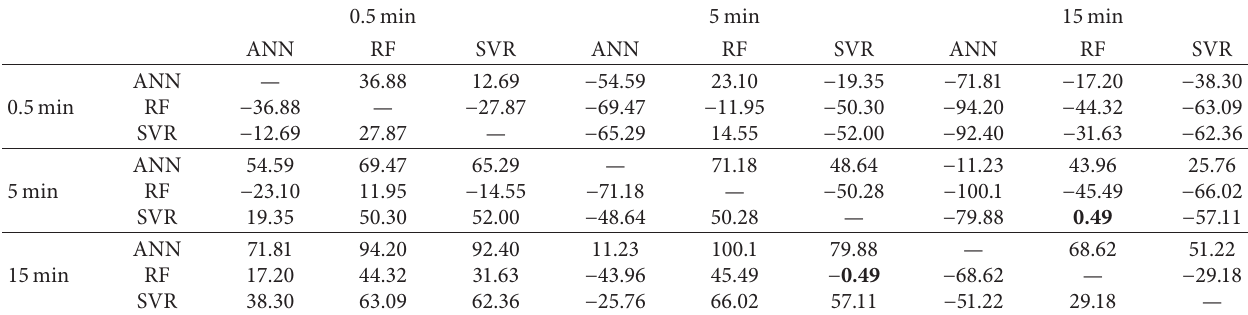
Standard deviations across segments are reported in parentheses and numbers in boldface show the best Table 2: Diebold–Mariano test statistic for each pair of models for predicting volume.